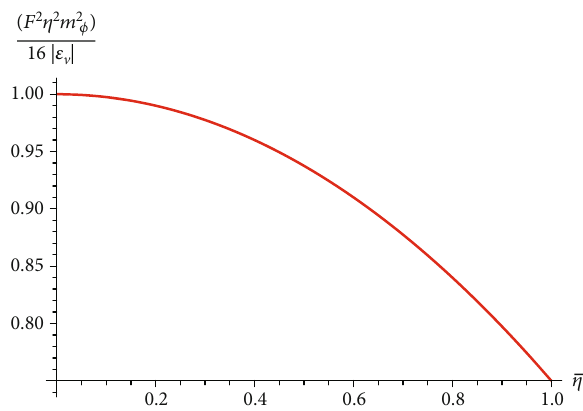
Figure 11: A graph of gluon condensate hð m 2 η 2 Þ F μν F / ð 16 ∣ ε ∣ Þ μν i ϕ v against T / T